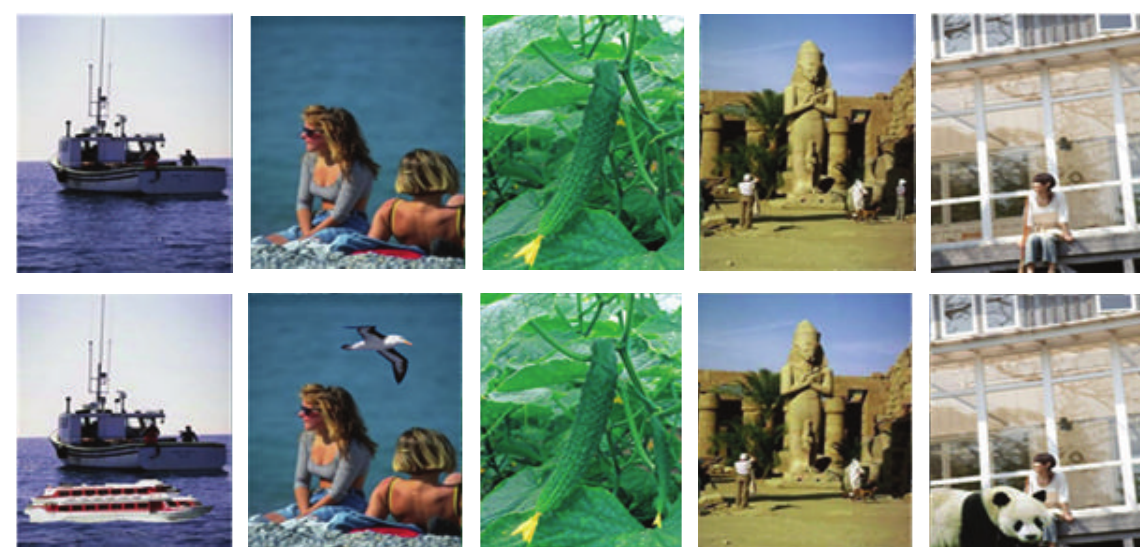
Figure 4: Examples of CASIA image dataset.